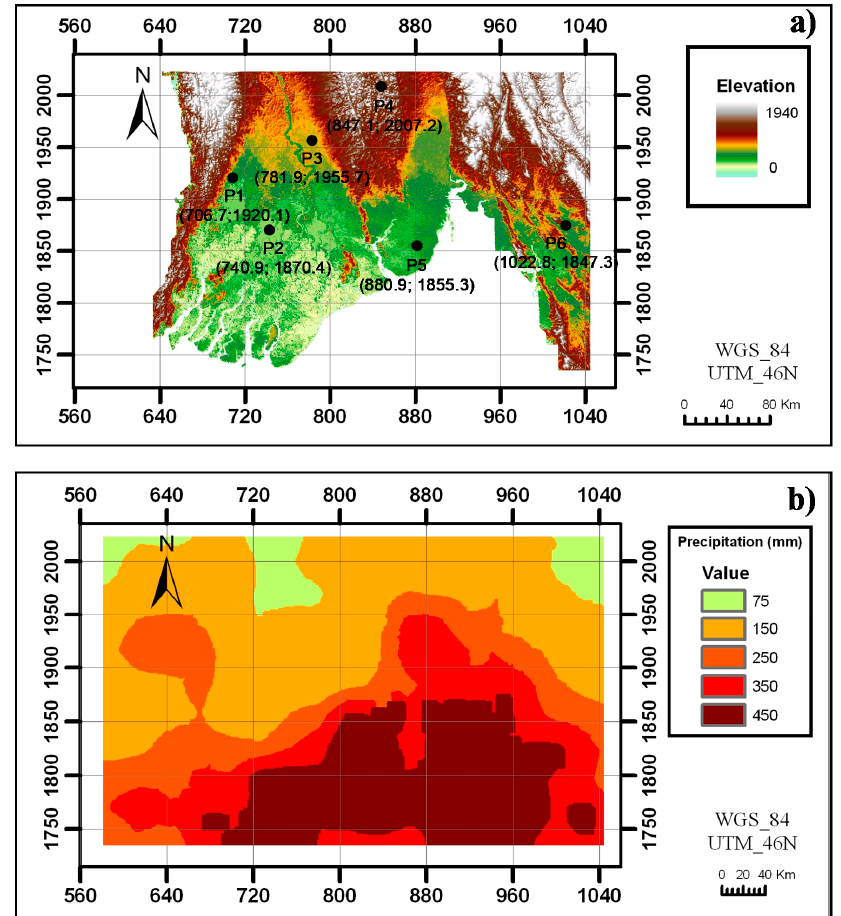
Figure 4. Topography and precipitation pattern along the study area; ( a ) digital elevation model (DEM); ( b ) Cumulative rainfall during Nargis.